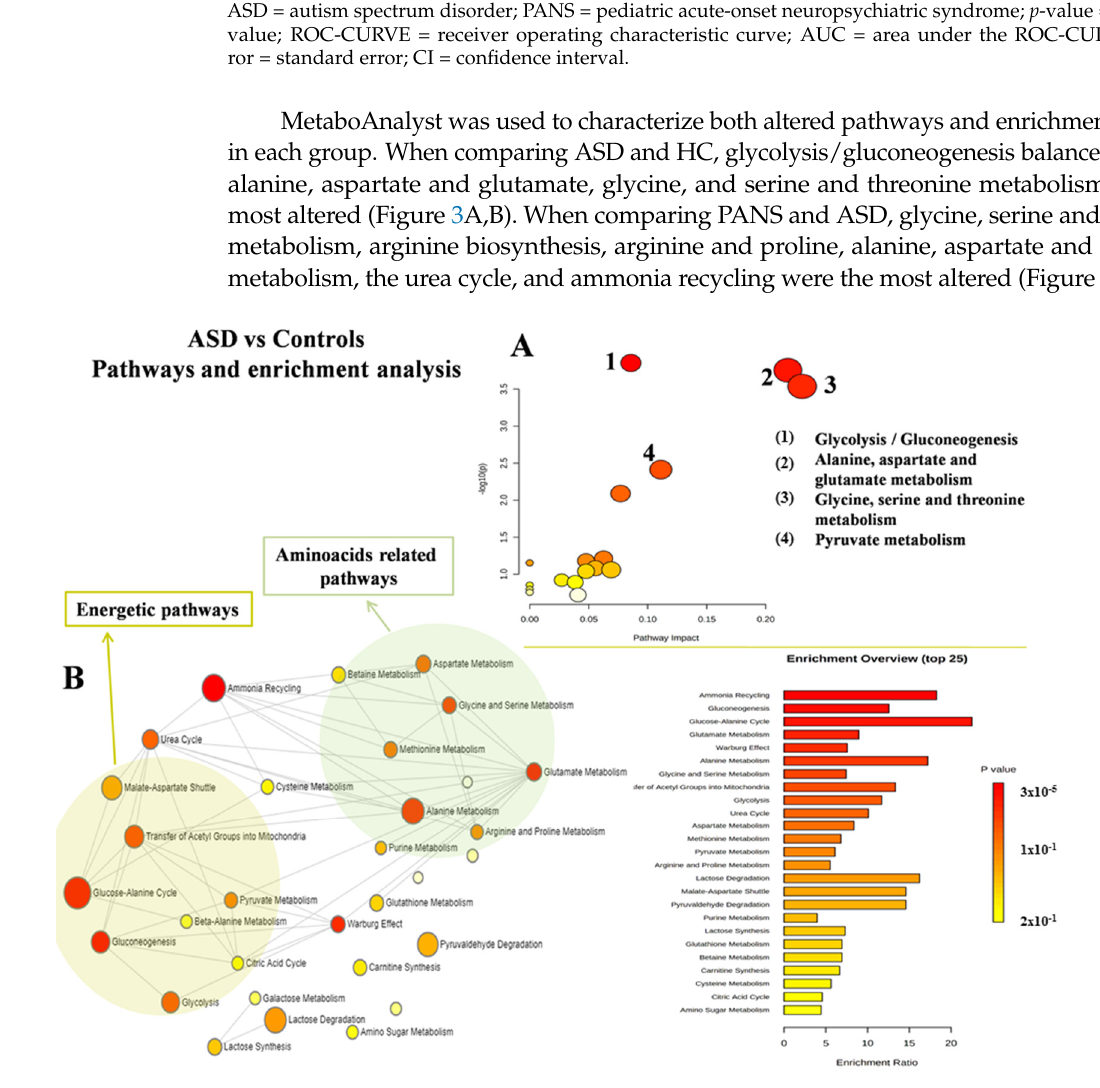
Figure 3. Metabolic pathways’ analysis ( A ) and enrichment analysis ( B ) of the comparison between control subjects and ASD patients. ASD = autism spectrum disorder.